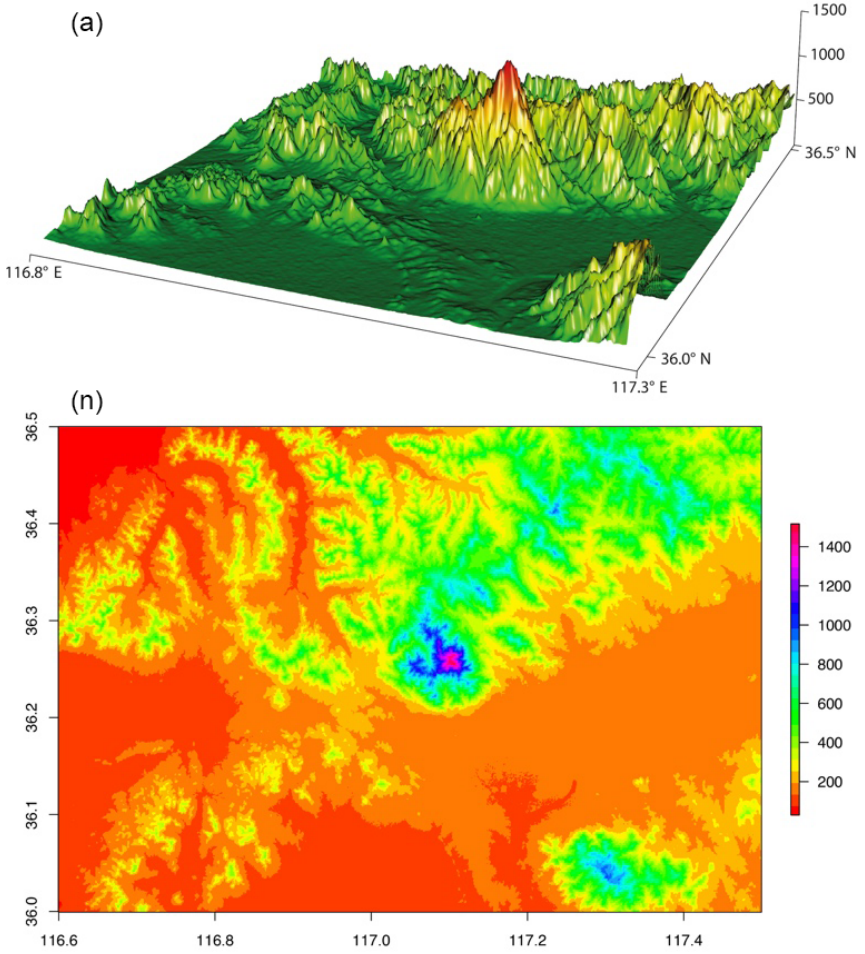
Figure 4. Topographic map of Mt. Tai and the surrounding region. In the top and bottom panels the altitude is shown by the z axis and by the color map, respectively, both with units of meters. The digital SRTM (NASA’s Shuttle Radar Topography Mission) elevation data are provided by the CIAT-CSI SRTM website (http://srtm.csi.cgiar.org; last access: 7 June